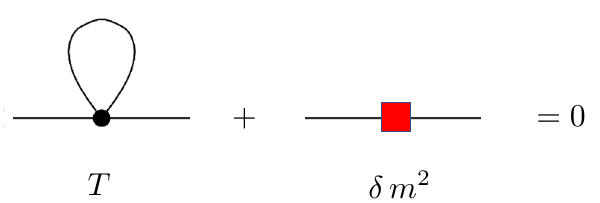
Figure 1. Diagrams for the first order tadpole diagram T and the corresponding relative mass counterterm δm 2 = − T ( m 0 )